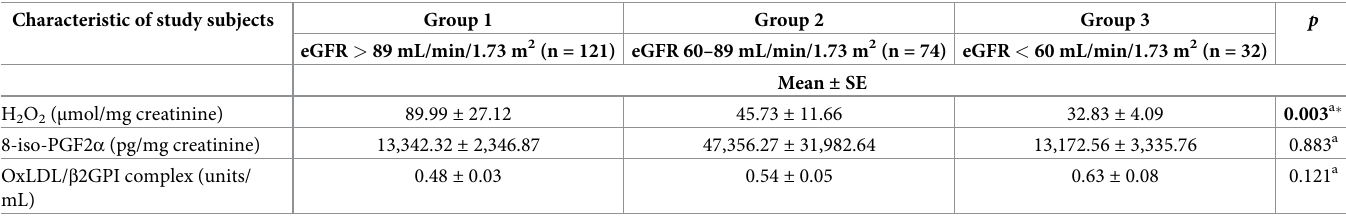
Table 2. Oxidative stress markers in study subjects. Characteristic of study